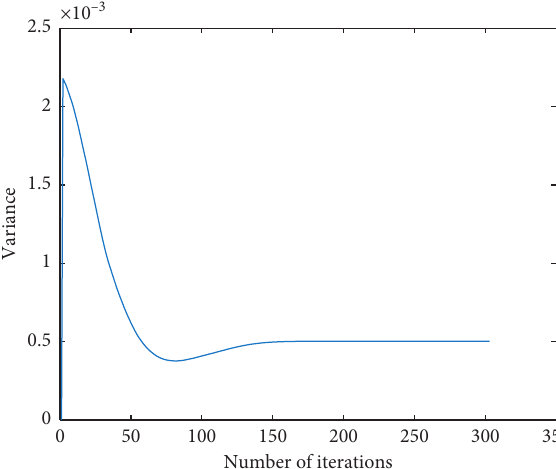
Figure 12: Changes in the variance of AdamSE